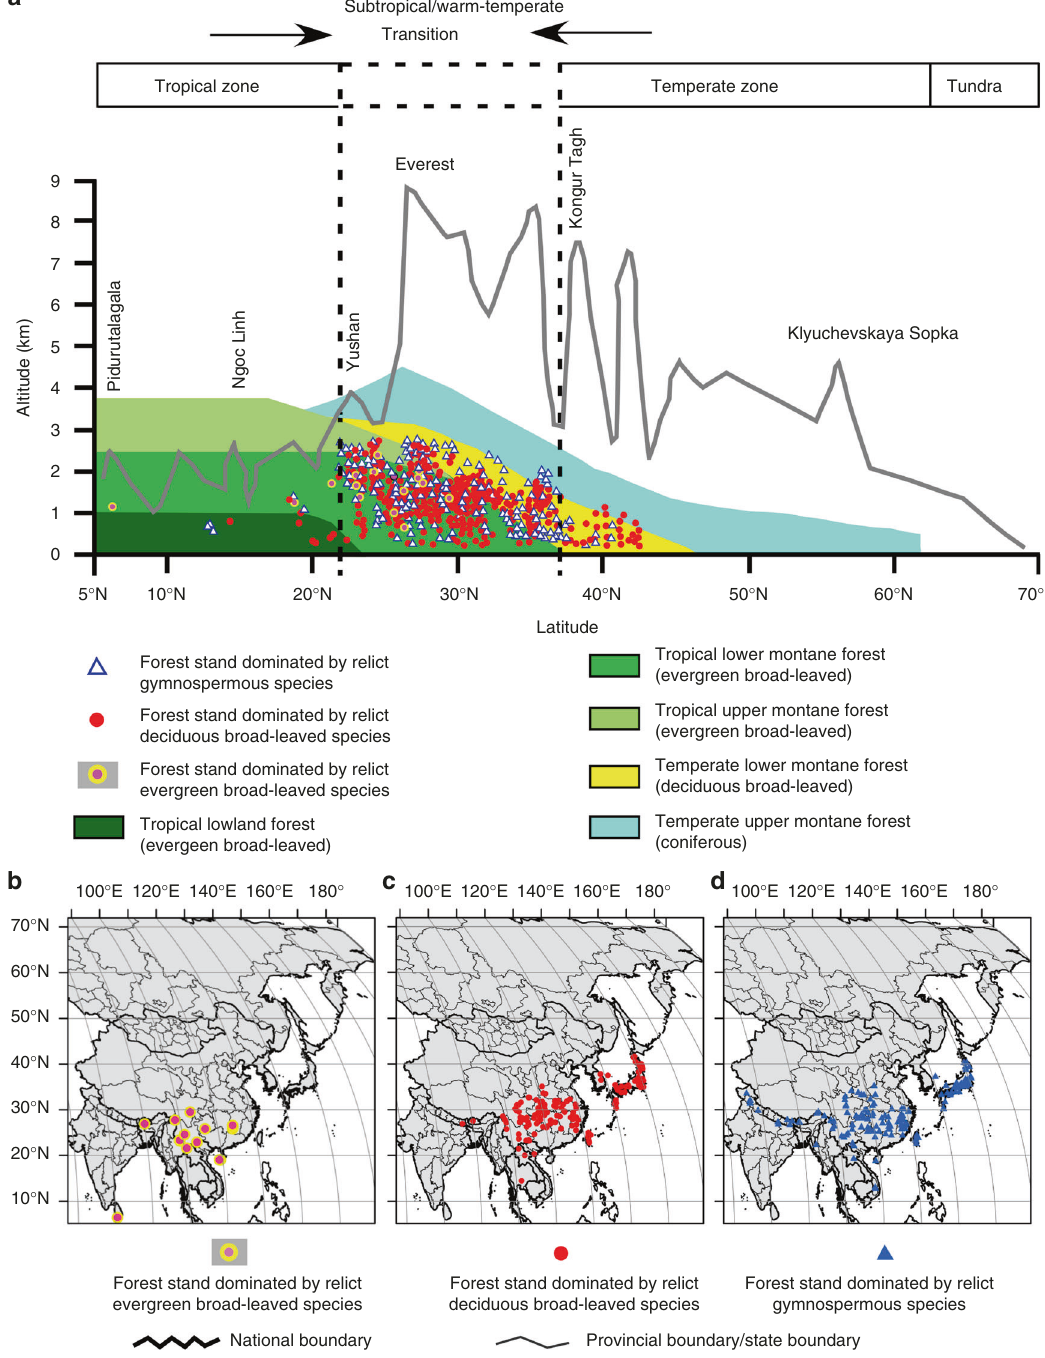
Fig. 2 Distribution of relict forest stands in East Asia. a Relict forest stands overlaid on a potential forest vegetation zone model and mountain pro fi le of East Asia. The potential forest vegetation zone model is modi fi ed from Ohsawa 80 . b – d Latitudinal and longitudinal distribution of relict forest stands in East Asia. For the national boundary between China and India, please see Supplementary Fig. 2A and Methods. Maps were generated using the software ArcGIS v. 10.5 (ESRI, Redlands, CA, USA) and modi fi ed using Canvas 12 (ACD Systems of America, Inc., Seattle, WA, USA). Map layers were obtained from site